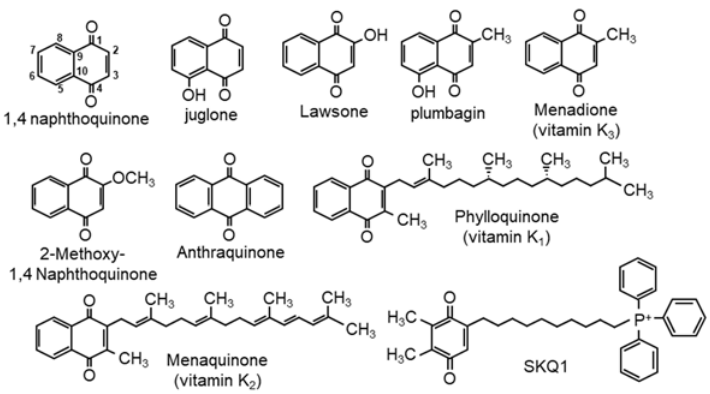
Figure 1. Structures of naphthoquinones used in this study; carbon positions are numbered in 1,4 ‐ naphthoquinone for reference.